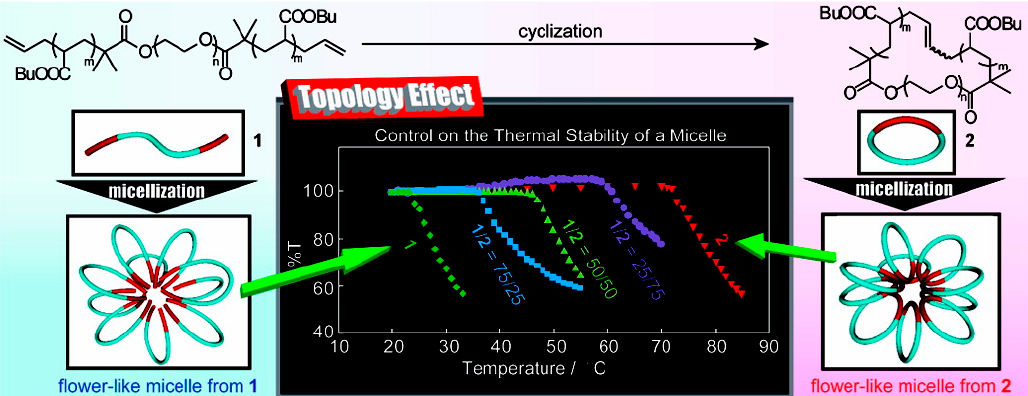
Figure 13. The schematic illustration of linear amphiphilic PBA- b -PEO- b -PBA and cyclic PBA- b -PEO- b -PBA self-assembly in aqueous media. The cyclic BCP shows an increased T c . Reprinted from Reference [83]. (Copyright (2010) American Chemical Society).